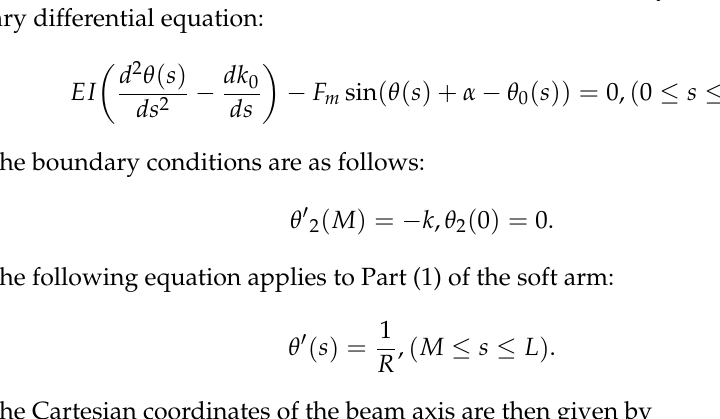
Figure 4. Diagram of the soft arm subjected to an external vertical